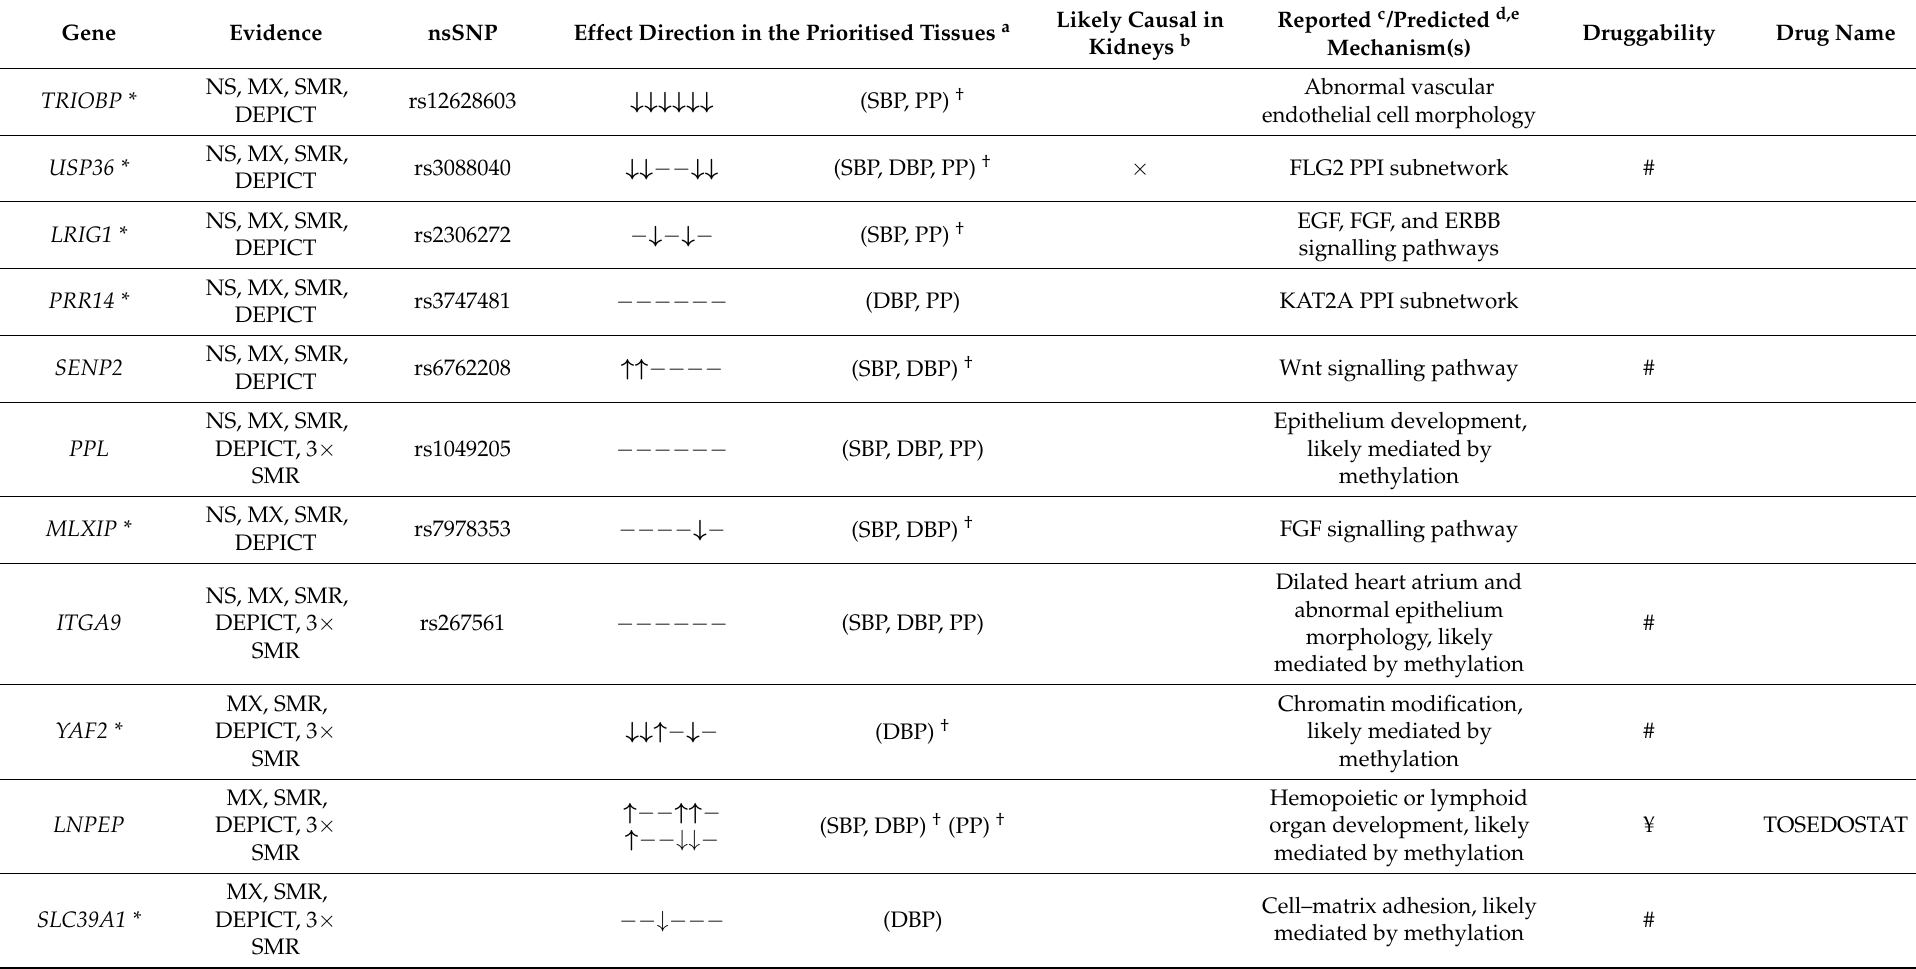
Table 1. The most highly prioritised genes with evidence from at least four different prioritization methods suggested for further follow-up